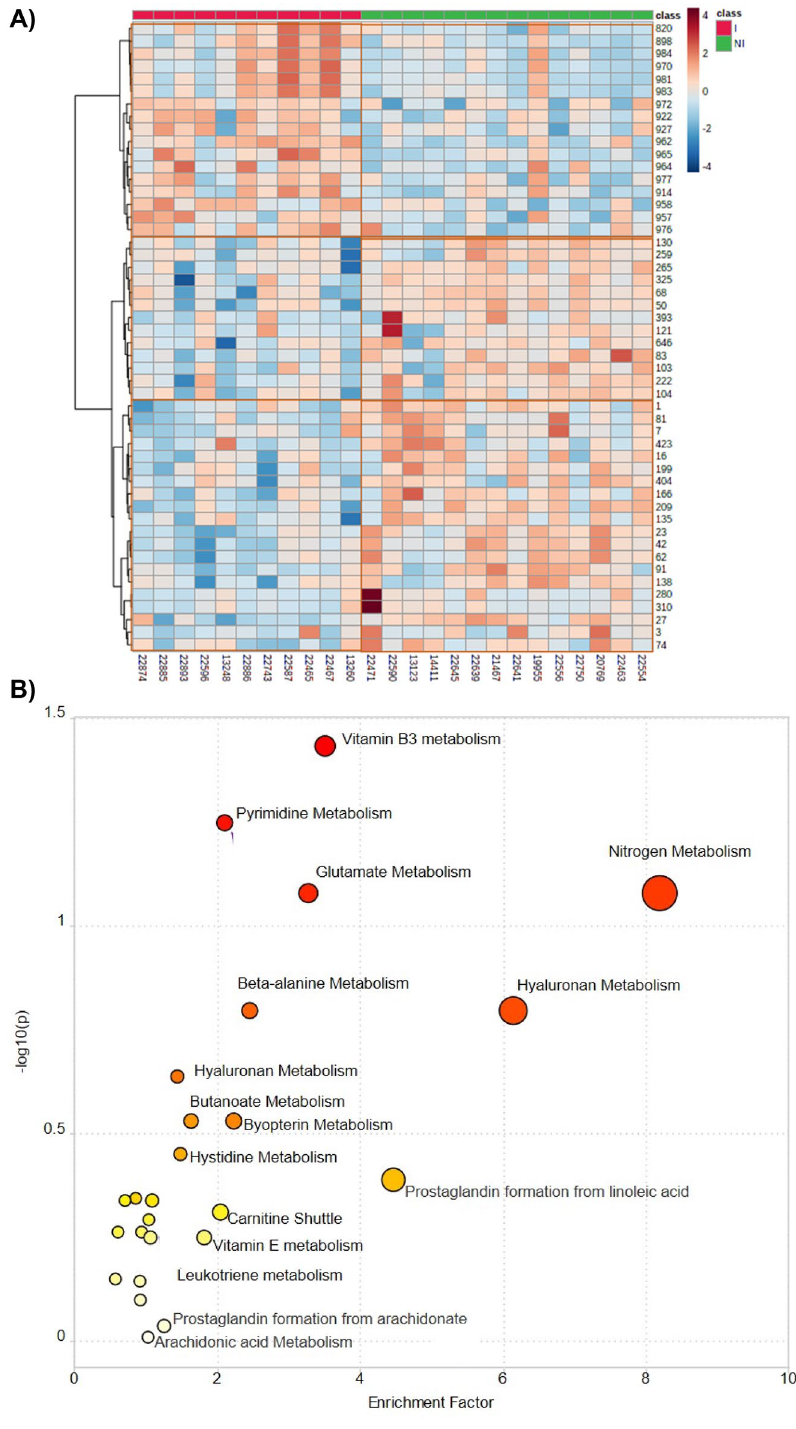
Figure 5. Ileal tissue from inflamed pediatric CD patients vs. non-inflamed have distinct metabolic signatures. ( A ) A dendrogram depicting relative abundances of the 50 most significant compounds (top to bottom) compared between inflamed ileal tissue (red, left) and non-inflamed ileal tissue (green, right) patients (left to right). Data was obtained with reverse phase liquid chromatography mass spectrometry (LC–MS) in positive ion mode. Detailed LC–MS compound information is detailed in Supplemental Table 2. Supplemental Table 2 clarifies the y-axis labels, which are the feature numbers, the compounds, their elemental formulas, their molecular weight, as their chromatographic retention time. ( B ) Pathway analysis of pilot data using the mummichog analytic approach showed the enrichment of multiple metabolites including vitamin B3 metabolism, pyrimidine metabolism, nitrogen metabolism and other lipid and amino acid pathways in CD compared to control tissue groups, in alignment with our in silico